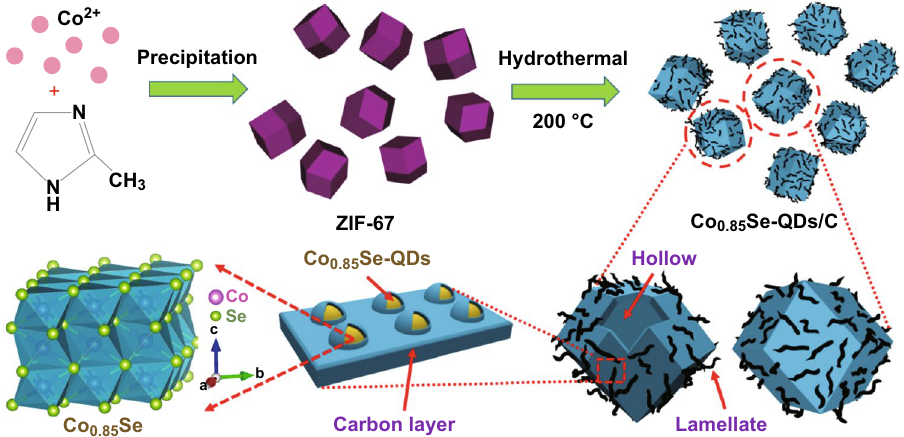
Fig. 1 Schematic illustration of the synthesis process for Co 0.85 Se‑QDs/C